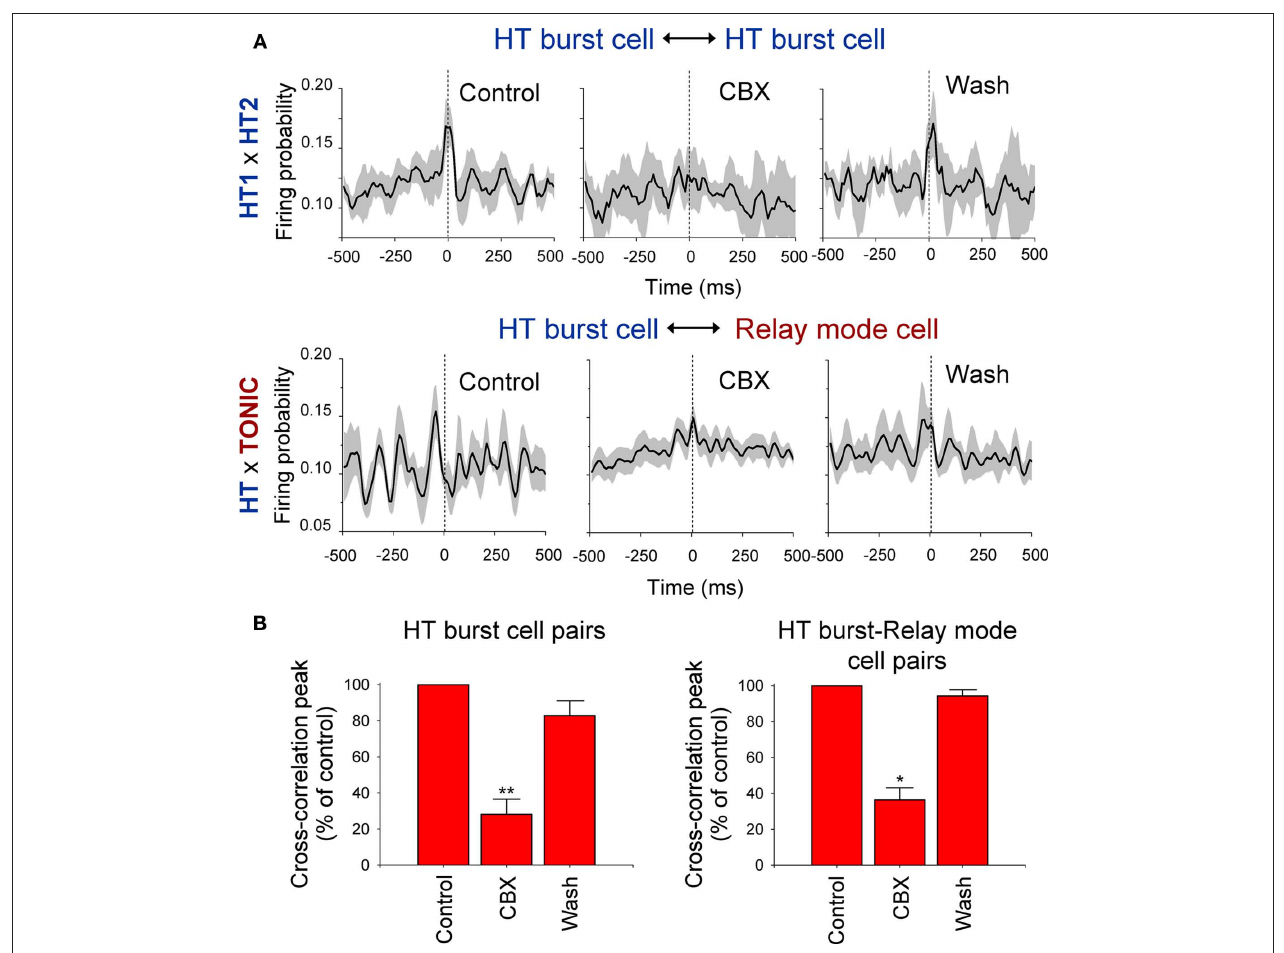
FiGurE 3 | Synchronized rhythmic firing of TC neurons during α rhythms is reversibly suppressed by the local administration of carbenoxolone (CBX). (A) Top: Average cross-correlograms of the activity of two simultaneously recorded LGN HT bursting TC neurons during 10 consecutive α rhythm epochs obtained from a Control period (left), during administration of 100 μM CBX (middle), and following